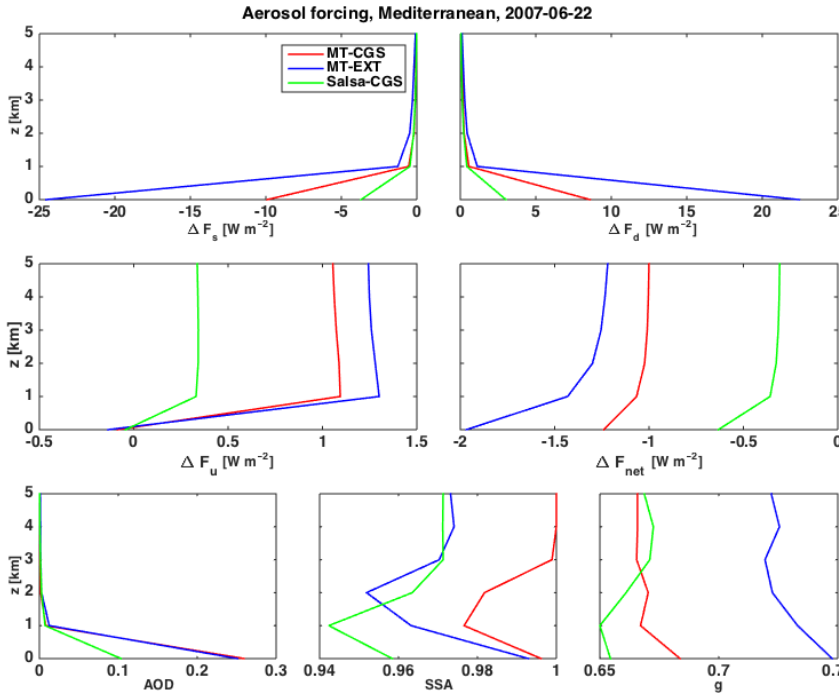
Figure 6. Same as Fig. 5 but over the